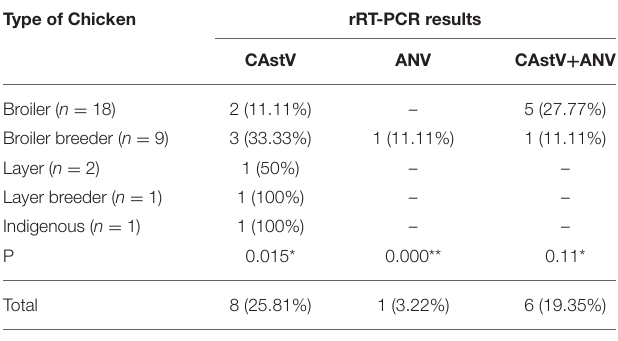
TABLE 4 | Identification of CAstV and ANV in types of chickens. Type of Chicken